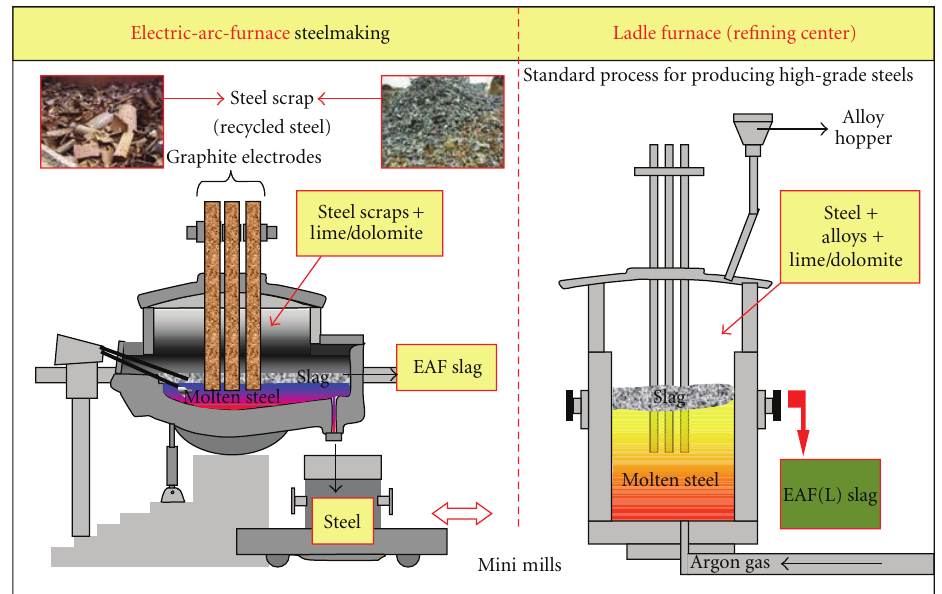
Figure 3: Schematic representation of the electric-arc-furnace steelmaking and ladle refining process [2,